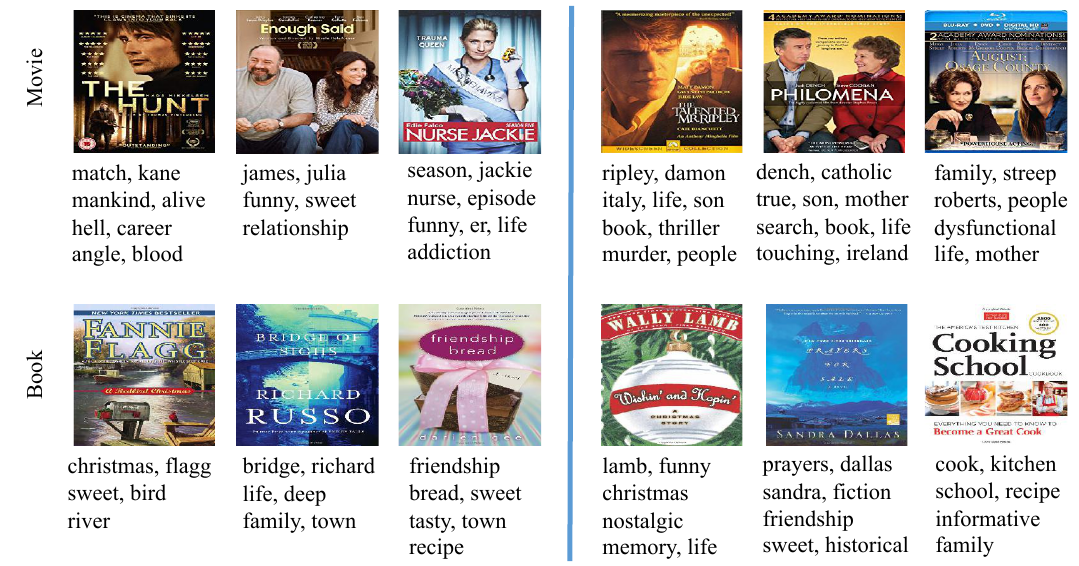
Figure 3. Case study for a Movie user ( top ) and a Book user ( bottom ): ( Left ) user’s top 3 favorite items. ( Right ) top 3 items our model